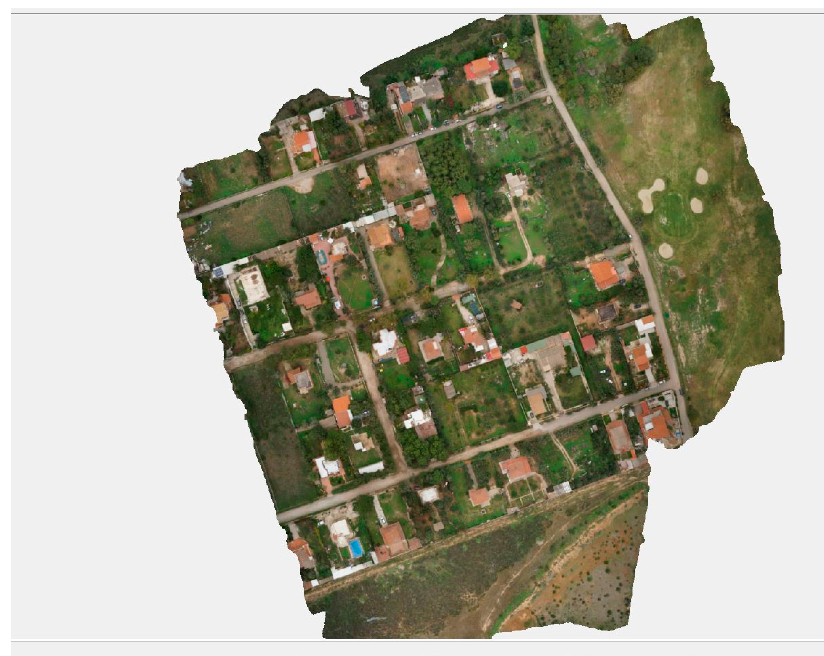
Figure 7. Photoscan raster DSM.